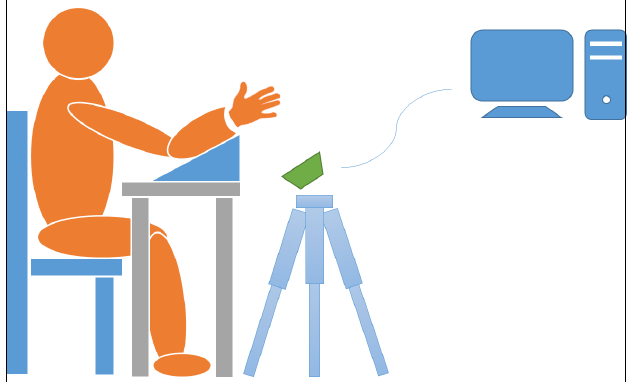
Figure 4. Setup of the measurement